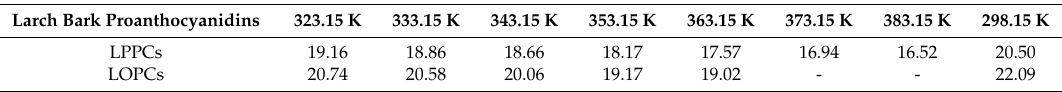
Table A6. Solubility parameter δ 2 of proanthocyanidins at di ff erent temperatures ((J / cm − 3 ) 0.5 ) (obtained by